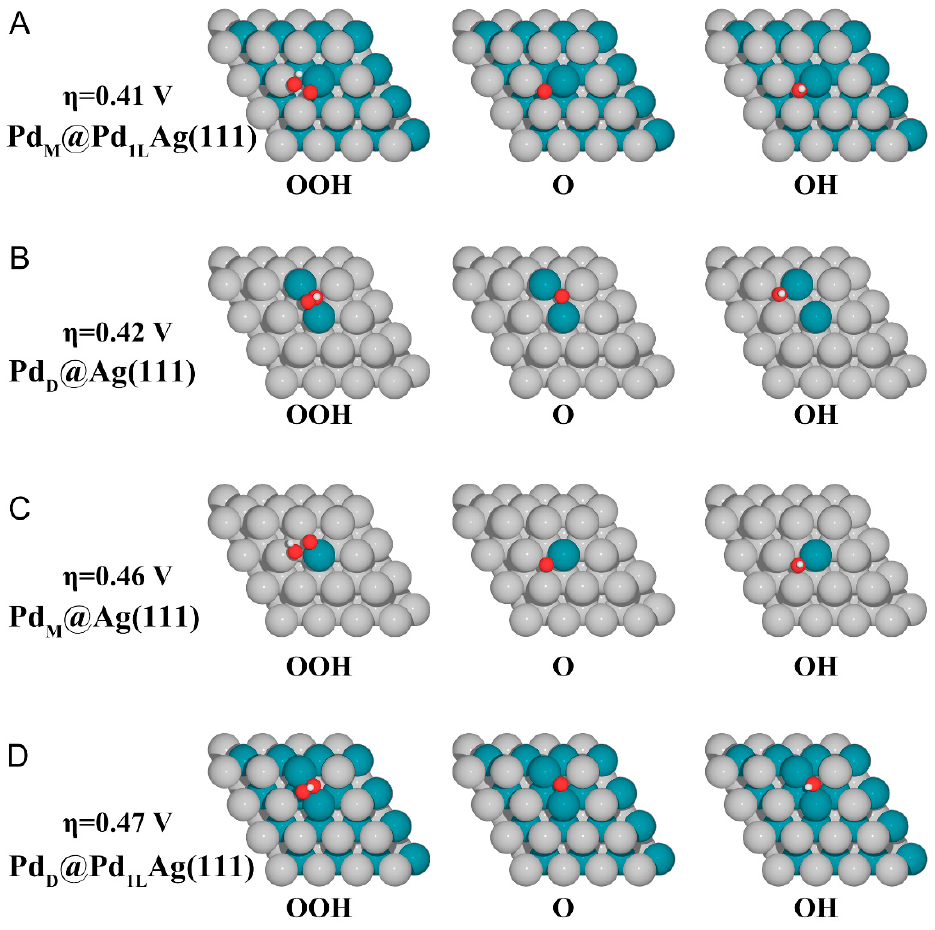
Figure 3. Top view of the atomistic structures of all ORR intermediates on the best four surfaces. ( A ) Pd M @Pd 1L Ag(111), ( B ) Pd D @Ag(111), ( C ) Pd M @Ag(111), and ( D ) Pd D @Pd 1L Ag(111). The silver, cyan, red, and white balls represent Ag, Pd, O, and H atoms, respectively.